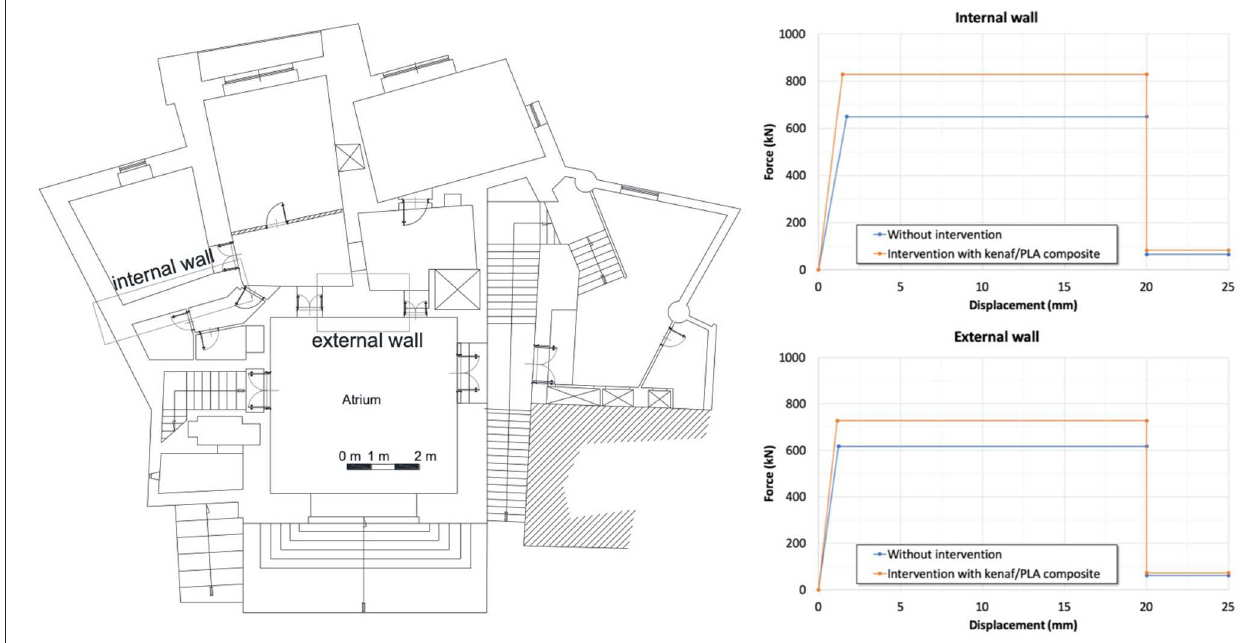
FIGURE 10 | Pushover curves of two walls belonging to the case study without and with the application of the kenaf/PLA